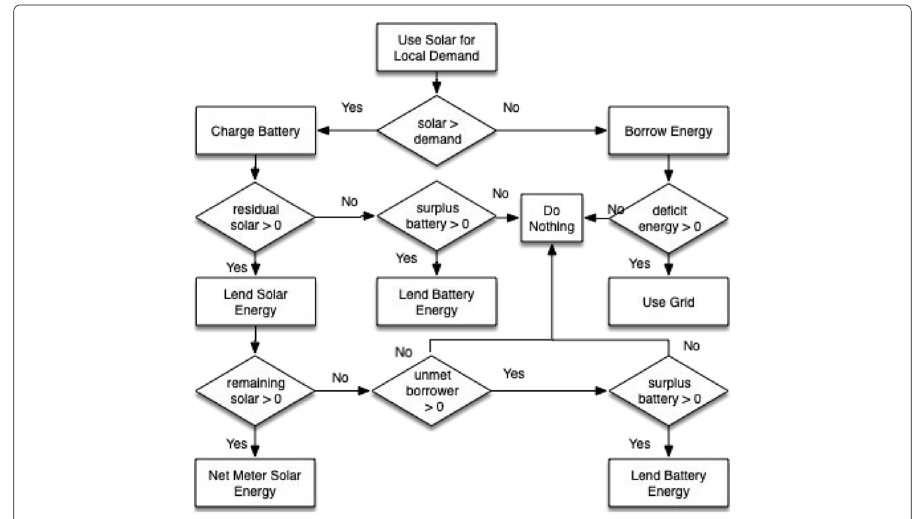
Fig. 3 A flow chart of AutoShare’s energy sharing